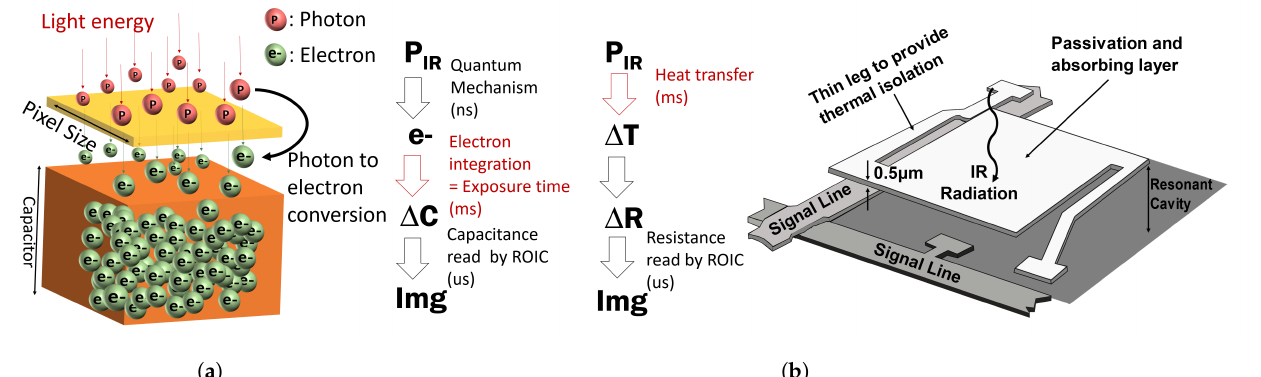
Figure 1. The mechanism of two different sensors and cause of motion blur. ( a ) the cause of motion blur in the photon detector is integration time, ( b ) the cause of motion blur in the thermal detector is the response time of temperature change.